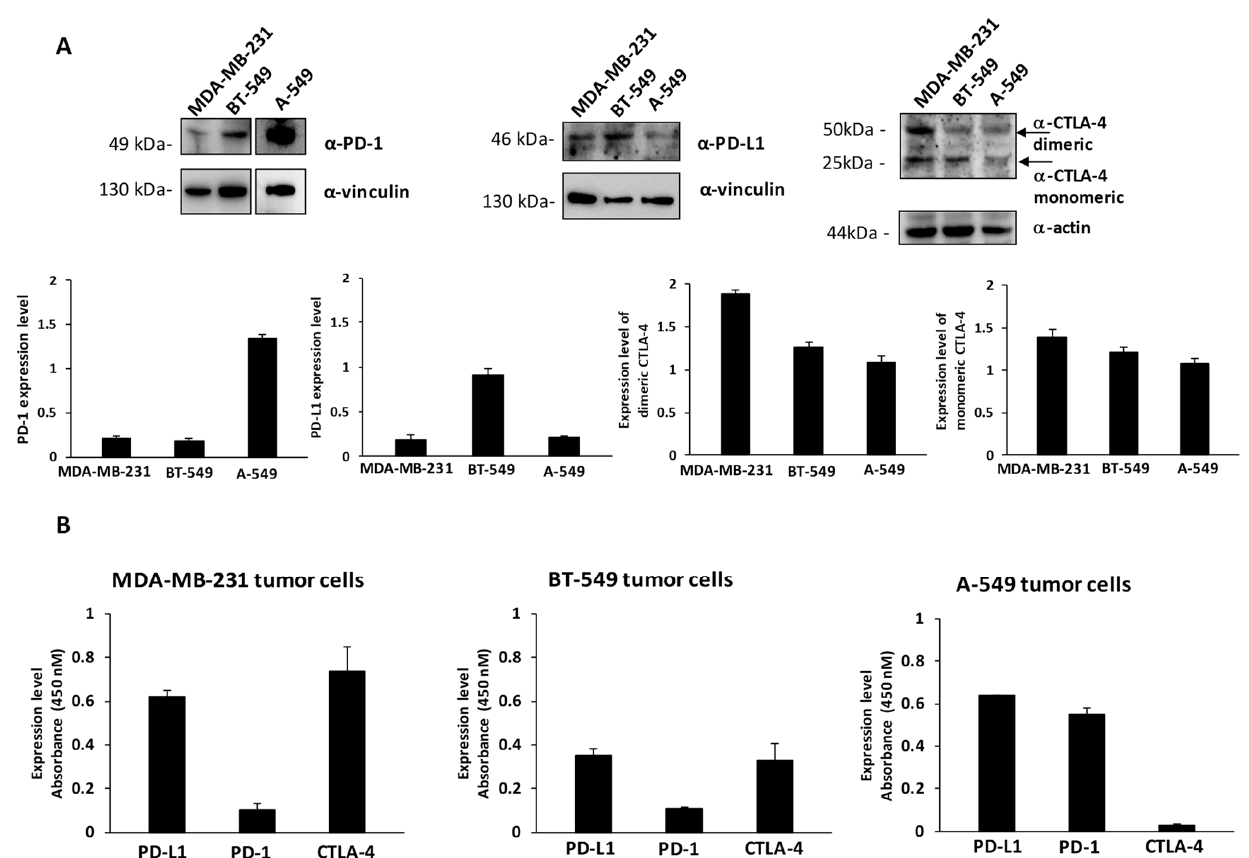
Figure 1. Expression of PD-L1, PD-1 and CTLA-4 ICs on cancer cells. ( A ) Western blotting analyses of extracts from MDA-MB-231, BT-549 and A-549 tumor cells, by using the commercial anti-PD-L1, anti-PD-1 or anti-CTLA-4 mAbs; the arrows indicate the dimeric and monomeric forms of CTLA-4. Full Western blots are included in the Figure S3. The intensity of the bands corresponding to ICs was normalized to actin or vinculin and their ratio is reported in the graphics as protein expression levels. ( B ) Cell ELISA assays were performed on whole cells to measure the cell surface expression of ICs with commercial anti-PD-1, anti-PD-L1 or anti-CTLA-4 mAbs on MDA-MB-231, BT549 or A-549 tumor cells. Binding values were reported as the mean of at least three determinations obtained in three independent experiments. Error bars depicted means ± SD.